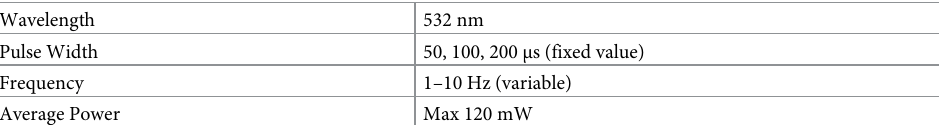
Table 1. Specifications of